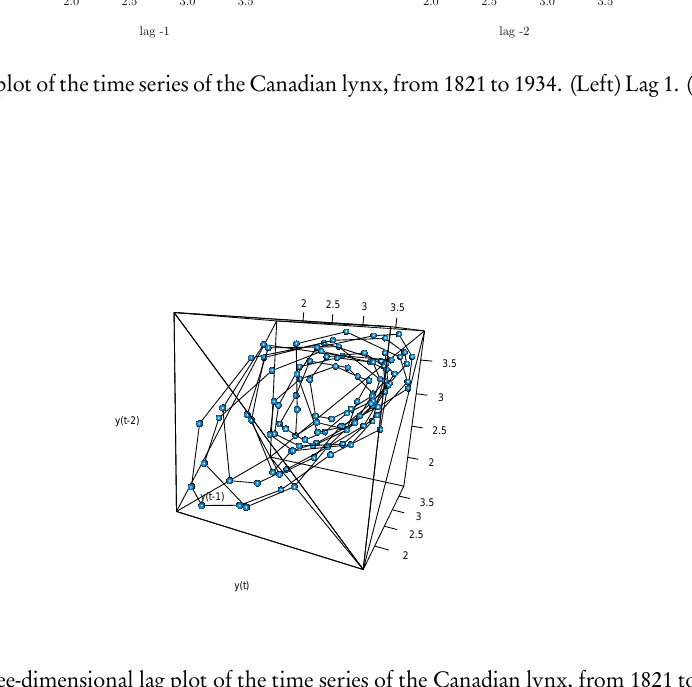
Figure 3 – Three-dimensional lag plot of the time series of the Canadian lynx, from 1821 to